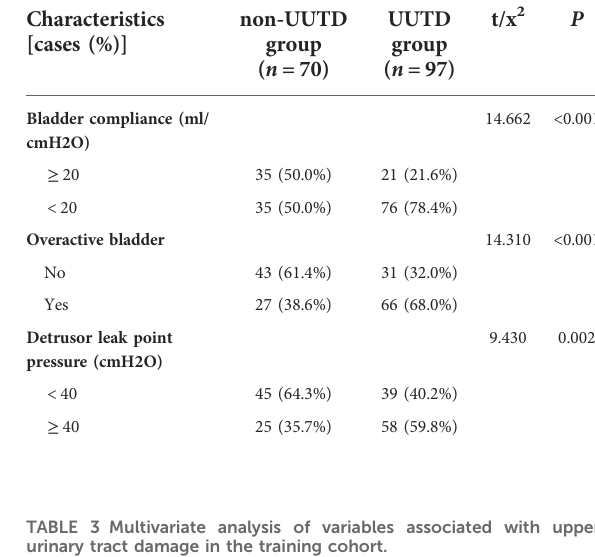
TABLE 3 Multivariate analysis of variables associated with upper urinary tract damage in the training